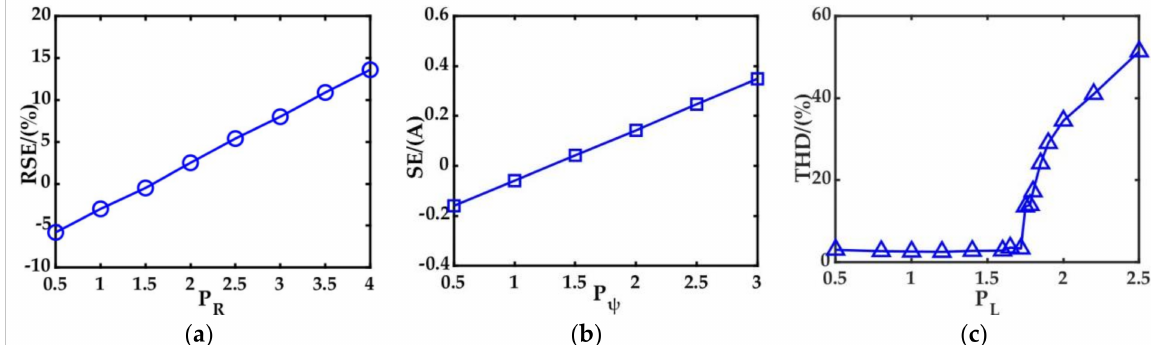
Figure 18. Relationships between current prediction errors and parameters mismatches. ( a ) Relative steady state error under mismatched stator winding resistance. ( b ) Steady state error under mismatched permanent magnet flux linkage. ( c ) Total harmonic distortion (THD) under mismatched stator inductance.